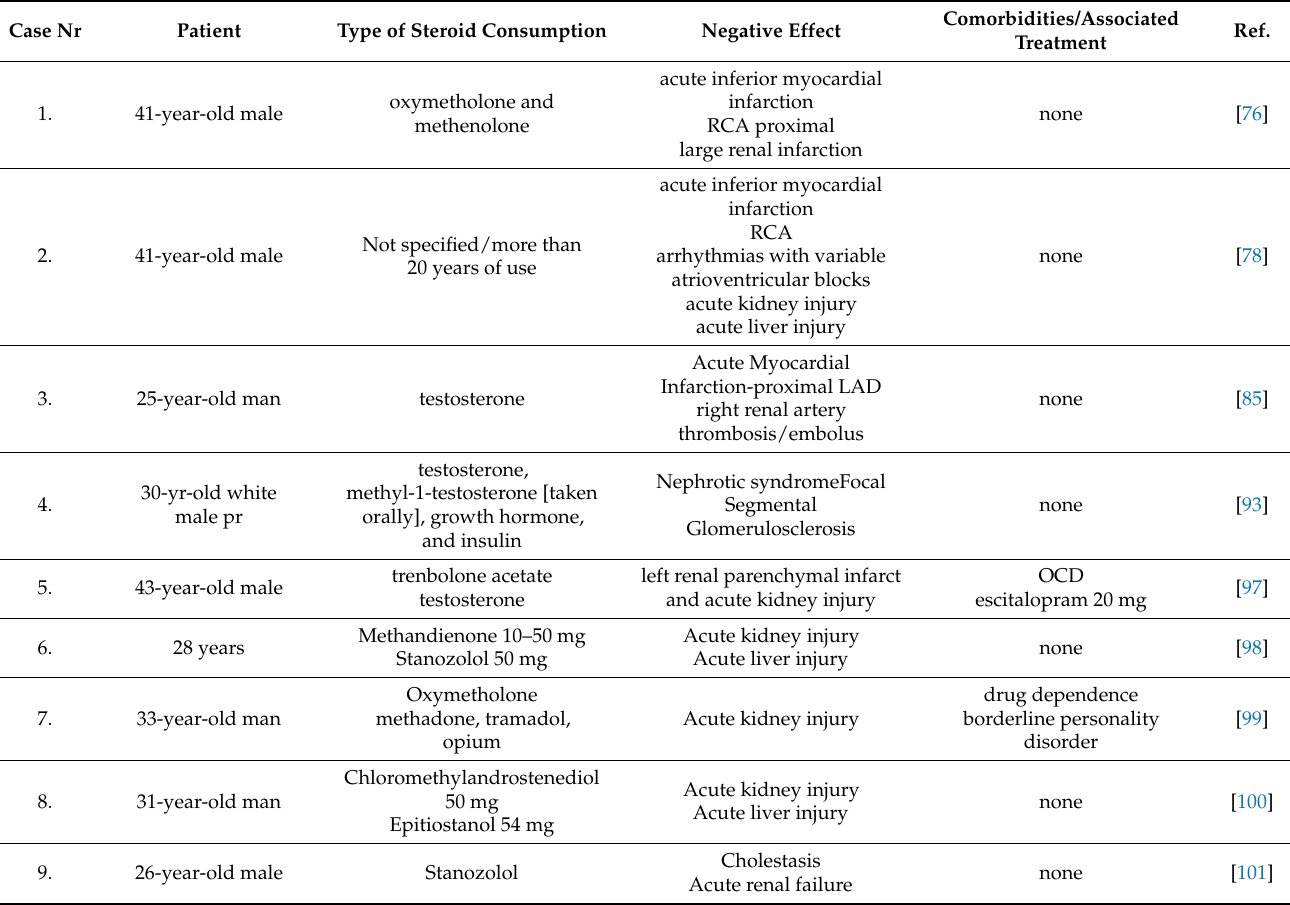
Table 5. Examples of kidney injury after AAS